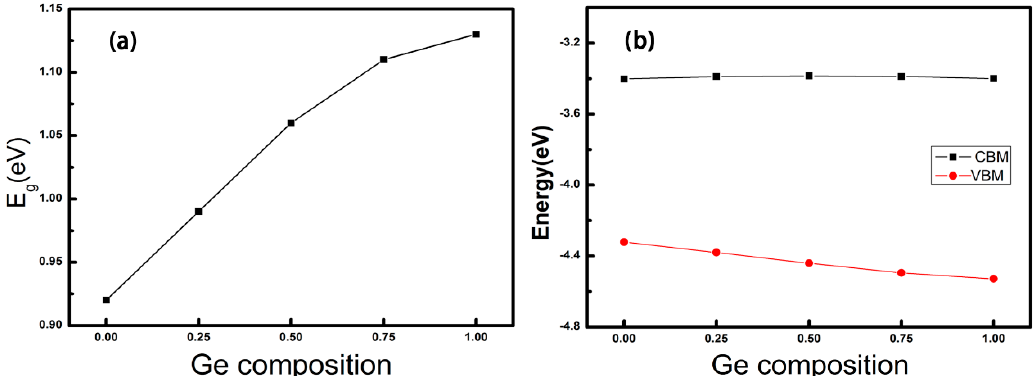
Figure 3. Calculated Band Gaps ( a ) and Band Edge Positions with Respect to Vacuum Energy Level ( b ) of Ge x Sn 1-x Se Monolayers as a Function of the Ge Concentration.